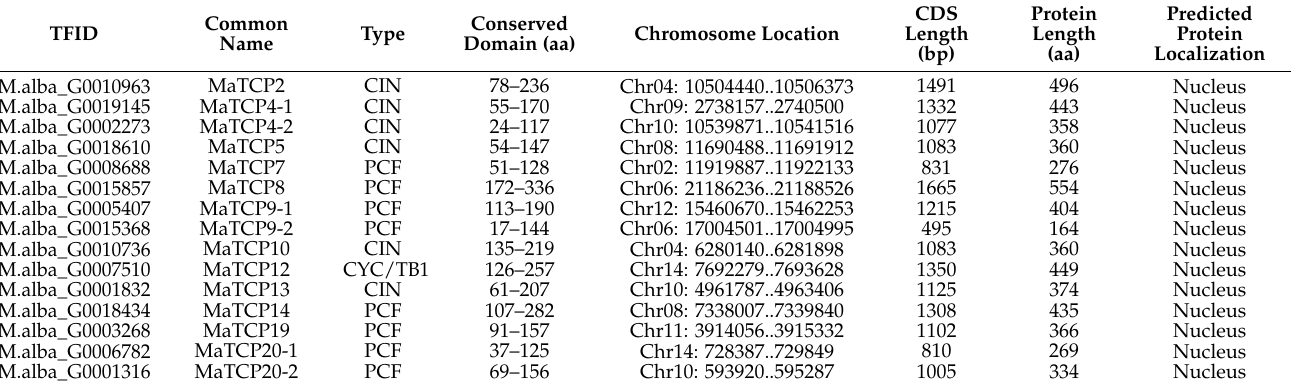
Table 1. Information on MaTCP proteins identified in this study.